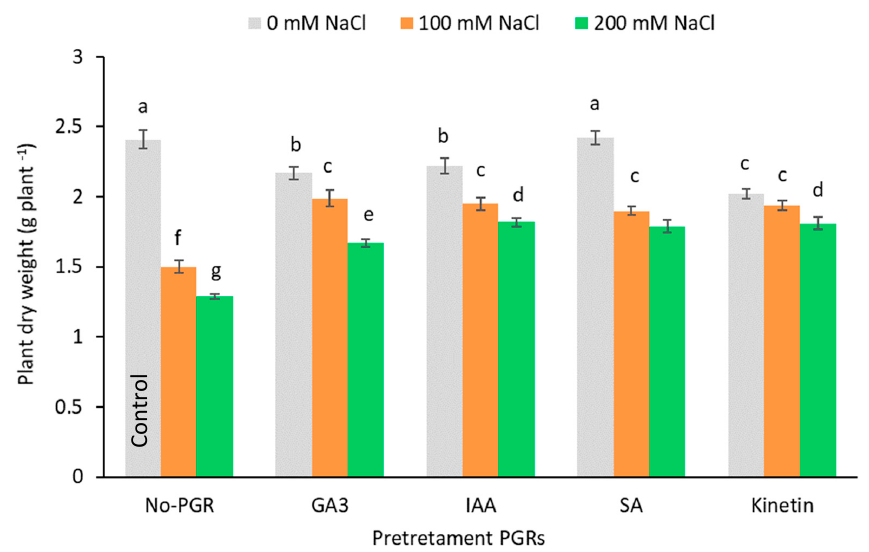
Figure 2. Effect of salt stress on plant dry weight of Olea europaea plants pretreated with plant growth regulators (PGRs). Data are expressed as mean ± SE (n = 6). Means followed by the same letter are not significantly different according to the LSD test ( p < 0.05). Table 1. Effect of salt stress on root dry weight, stem dry weight, leaf dry weight, and leaf relative water content (LRWC) of Olea europaea plants pretreated with plant growth regulators (PGRs). Data are expressed as mean ± SE (n =